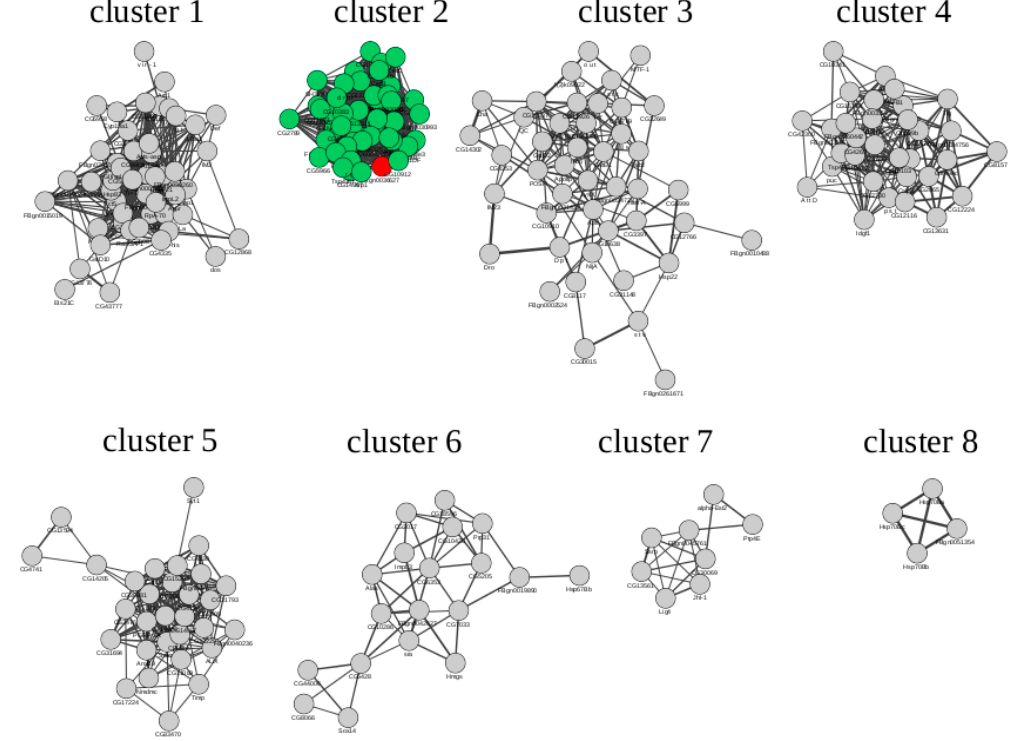
Figure 6. Co-expression clusters of genes with virus-induced expression (according to GEO: GSE2828, GSE31542, GSE42255). The genes in the cluster with Gagr (cluster 2) are marked in green, the Gagr gene is marked in red.